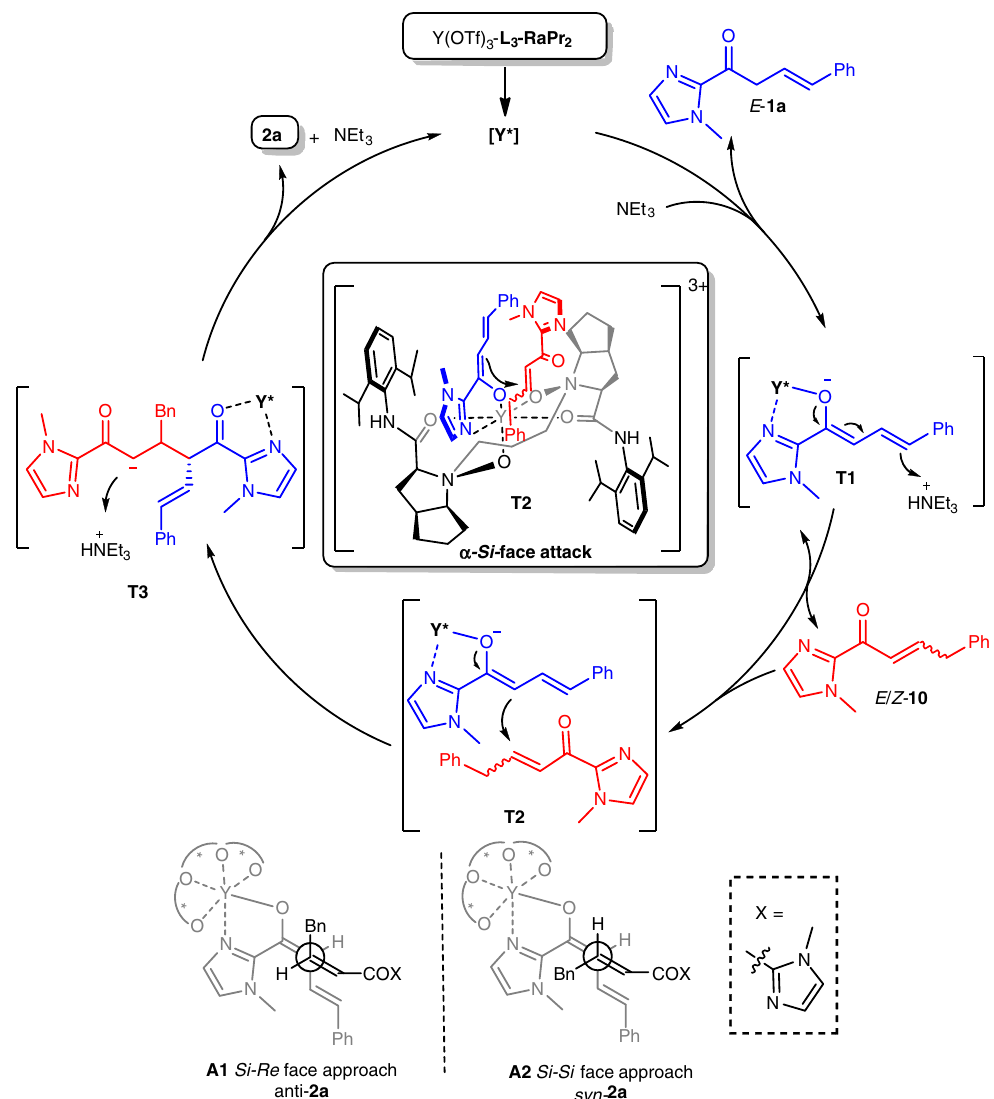
Fig. 8 Proposed catalytic cycle. The in situ formed chiral catalyst [ Y* ] catalyzes isomerization of E - 1a into E / Z -10 in the presence of NEt 3 , followed by nucleophilic addition of E - 1a and protonation to deliver the fi nal product 2a